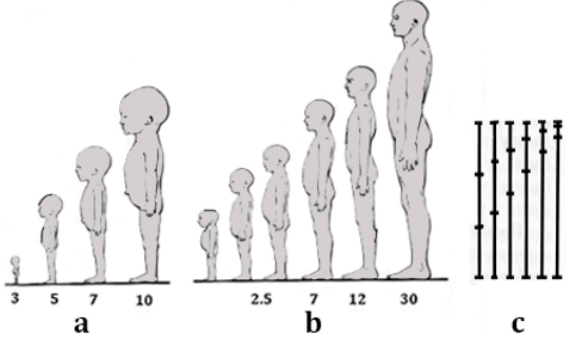
Fig. 2 . Age-related changes in the proportions of the human body (from [3]). a, b - antenatal and postnatal stages: a - in the lunar months; b - in years (first newborn on the left); c - examples of projectively equivalent three-term segments, the cross-ratio values of which are equal to